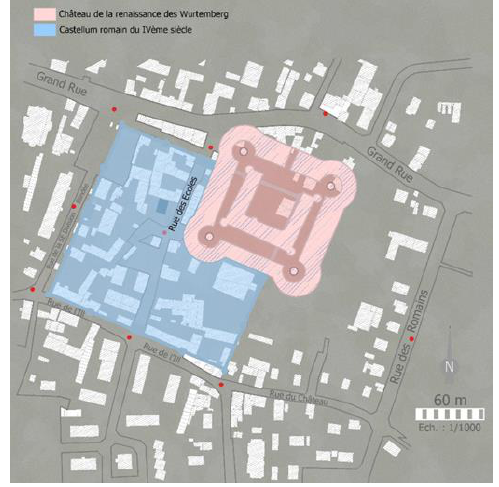
Figure 6: Schematic of the castellum and 16 th Century castle (topographic map dating from 1900 repositioned on the cadastral background of Horbourg-Wihr) Similar sites in terms of geography and of time period Close similar sites in terms of architecture, geographical location and of time-period were visited to be inspired by them. Saalburg similar Roman vestiges.